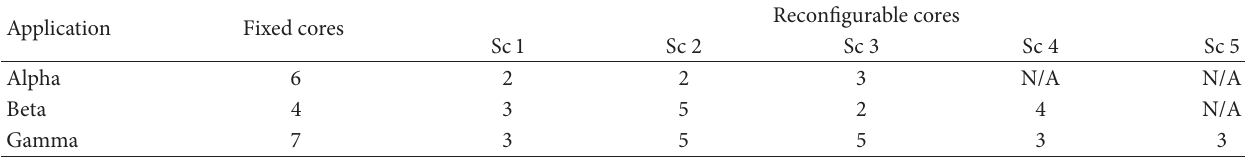
Table 1: Characteristics of synthetic applications.